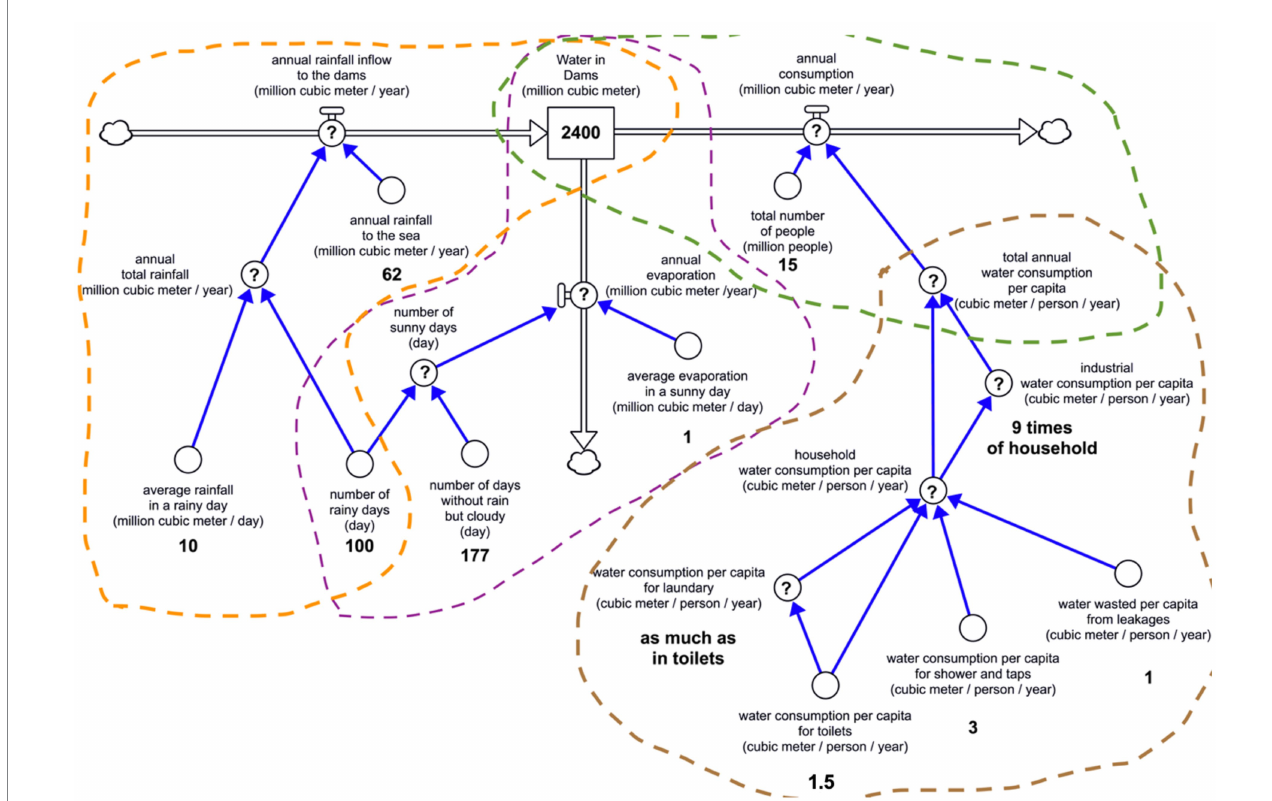
FIGURE 3 Jigsaw problem students complete and then